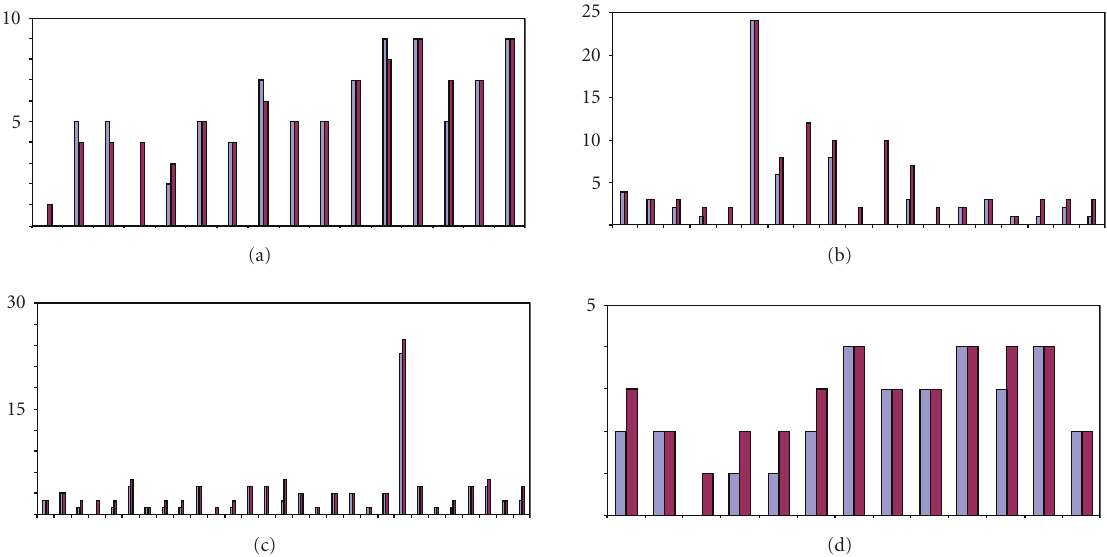
Figure 9: Examples of the duration time of each blink: true blink duration versus detected blink duration. The heights of the bars show the blink duration (in terms of frame numbers). In each pair of bars, the left (blue) bar shows the duration of the detected blink, and the right bar (magenta) shows that of the true